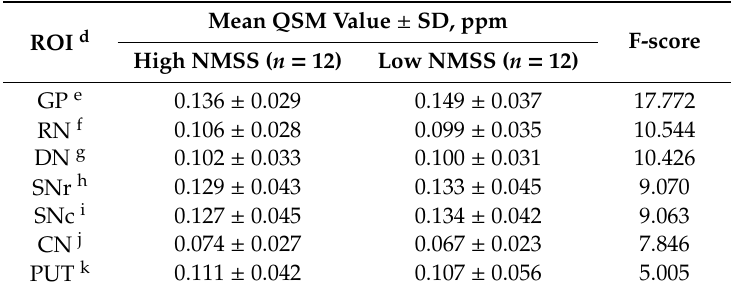
Table 4. QSM a values and F-scores b for patients with high or low NMSS c score. ROI